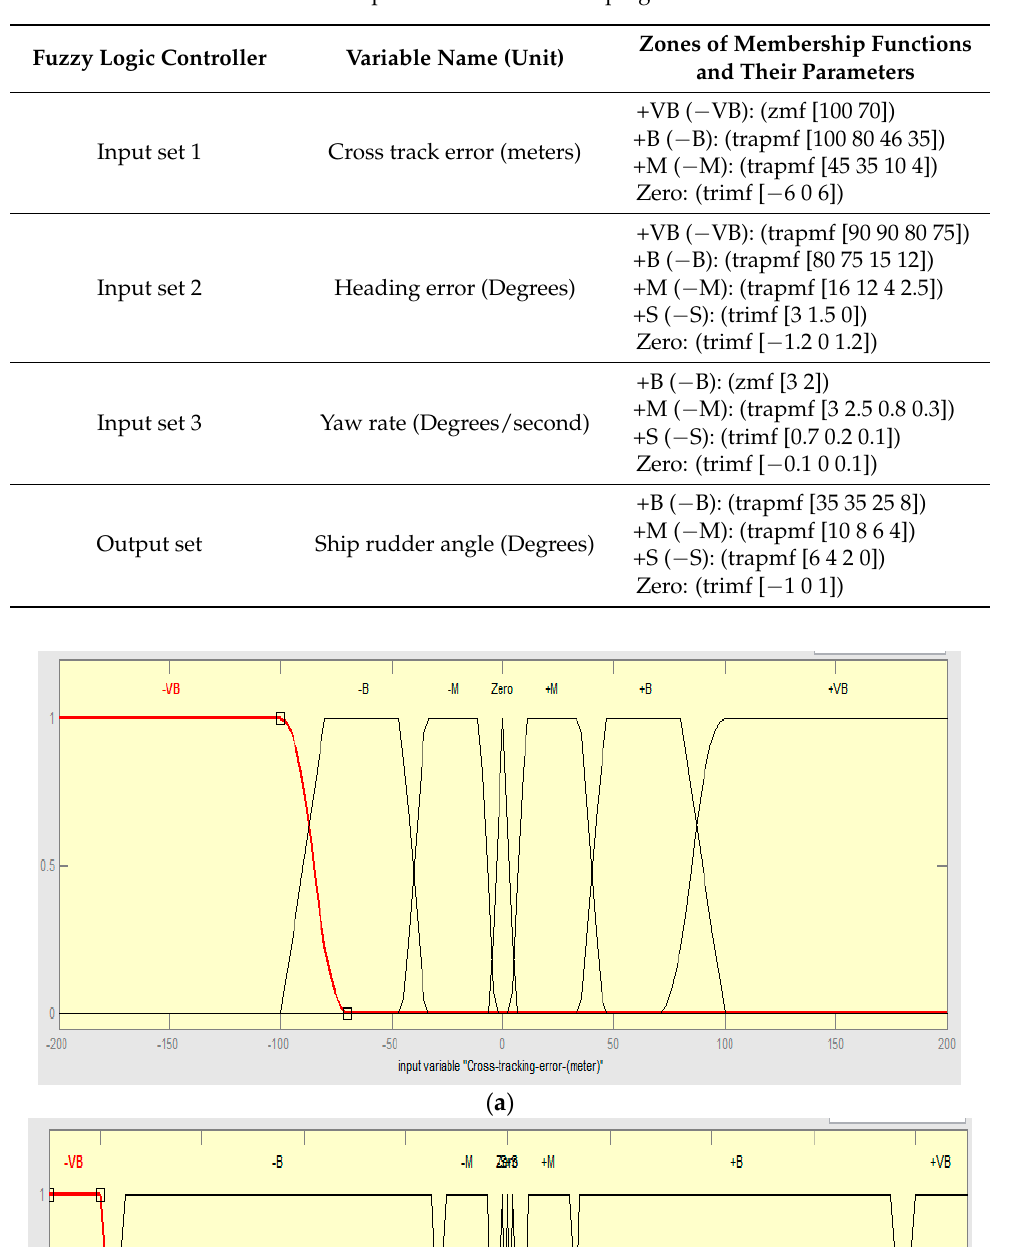
Table 3. The parameters of track-keeping controller.